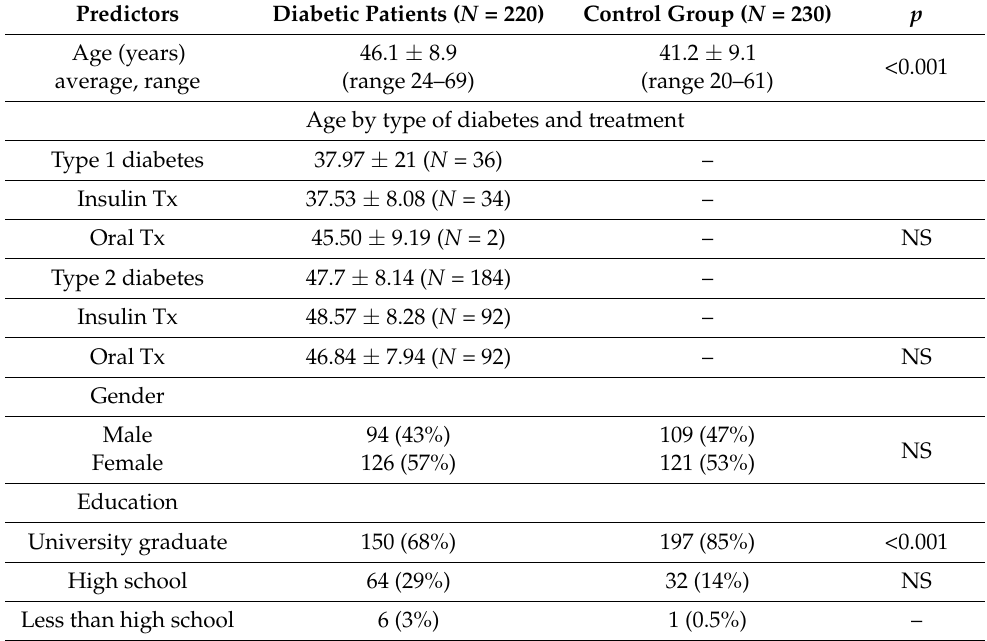
Table 1. Population sociodemographic